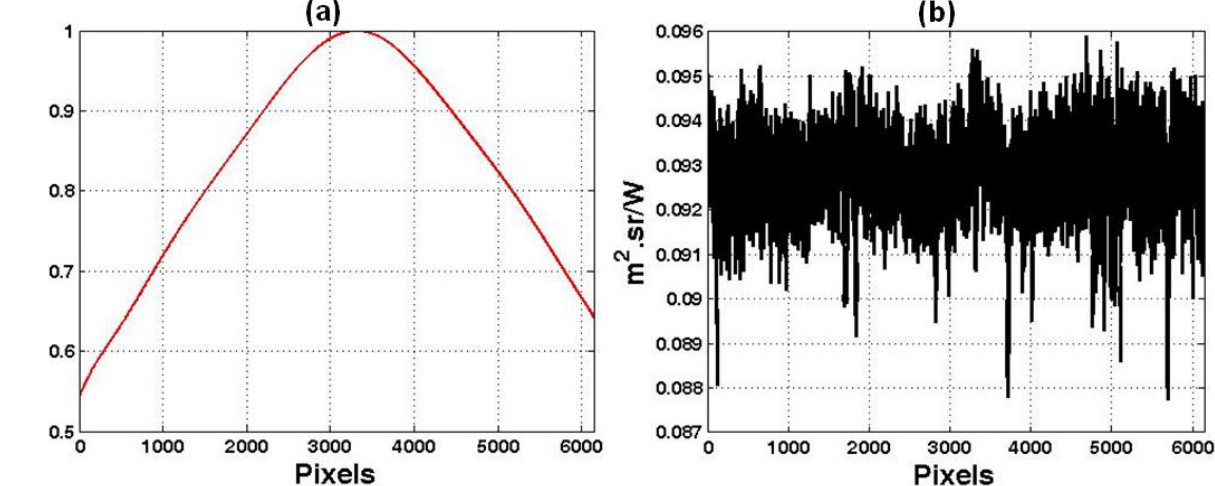
Figure 4. (a) Vignette effect correction coefficients— VE(i) . (b) Quantum efficiency calibration coefficient— QE(i)